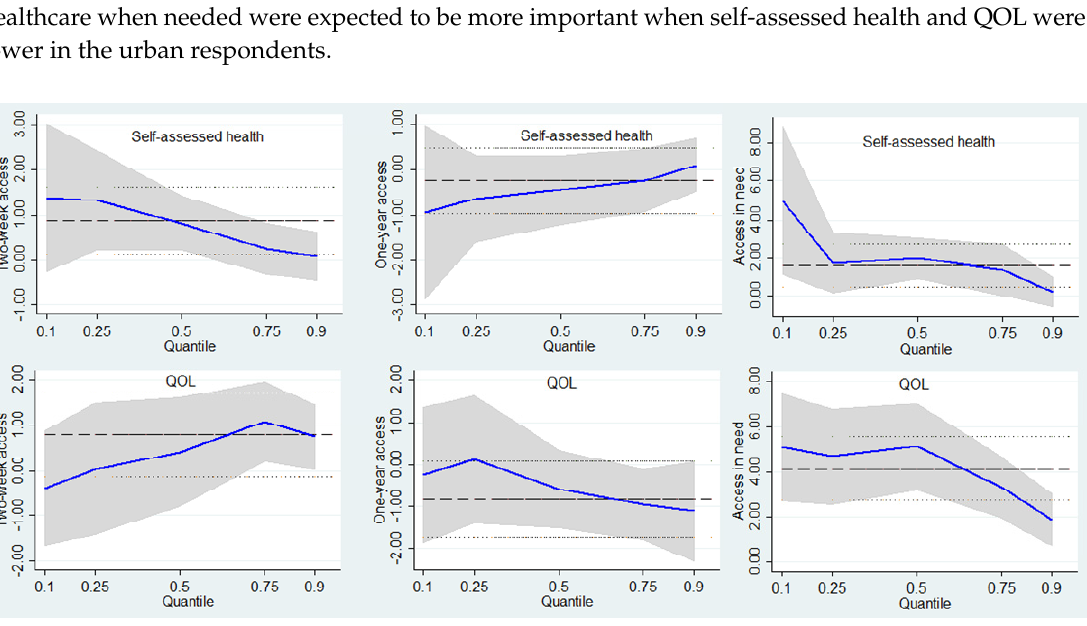
Figure 1. Point estimates and 95% confidence intervals from a quantile regression of the self-assessed health and QOL distribution for urban